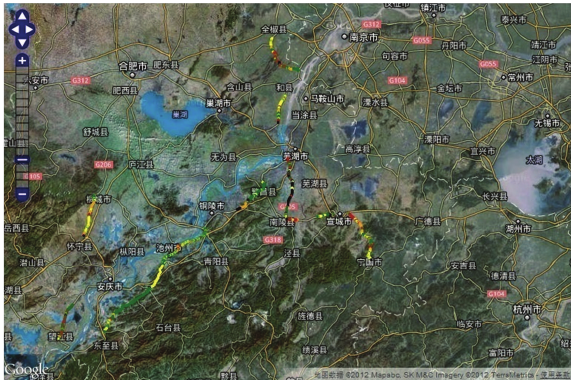
Figure 3: RIOH all occupants of risk rating map with countermea- sures